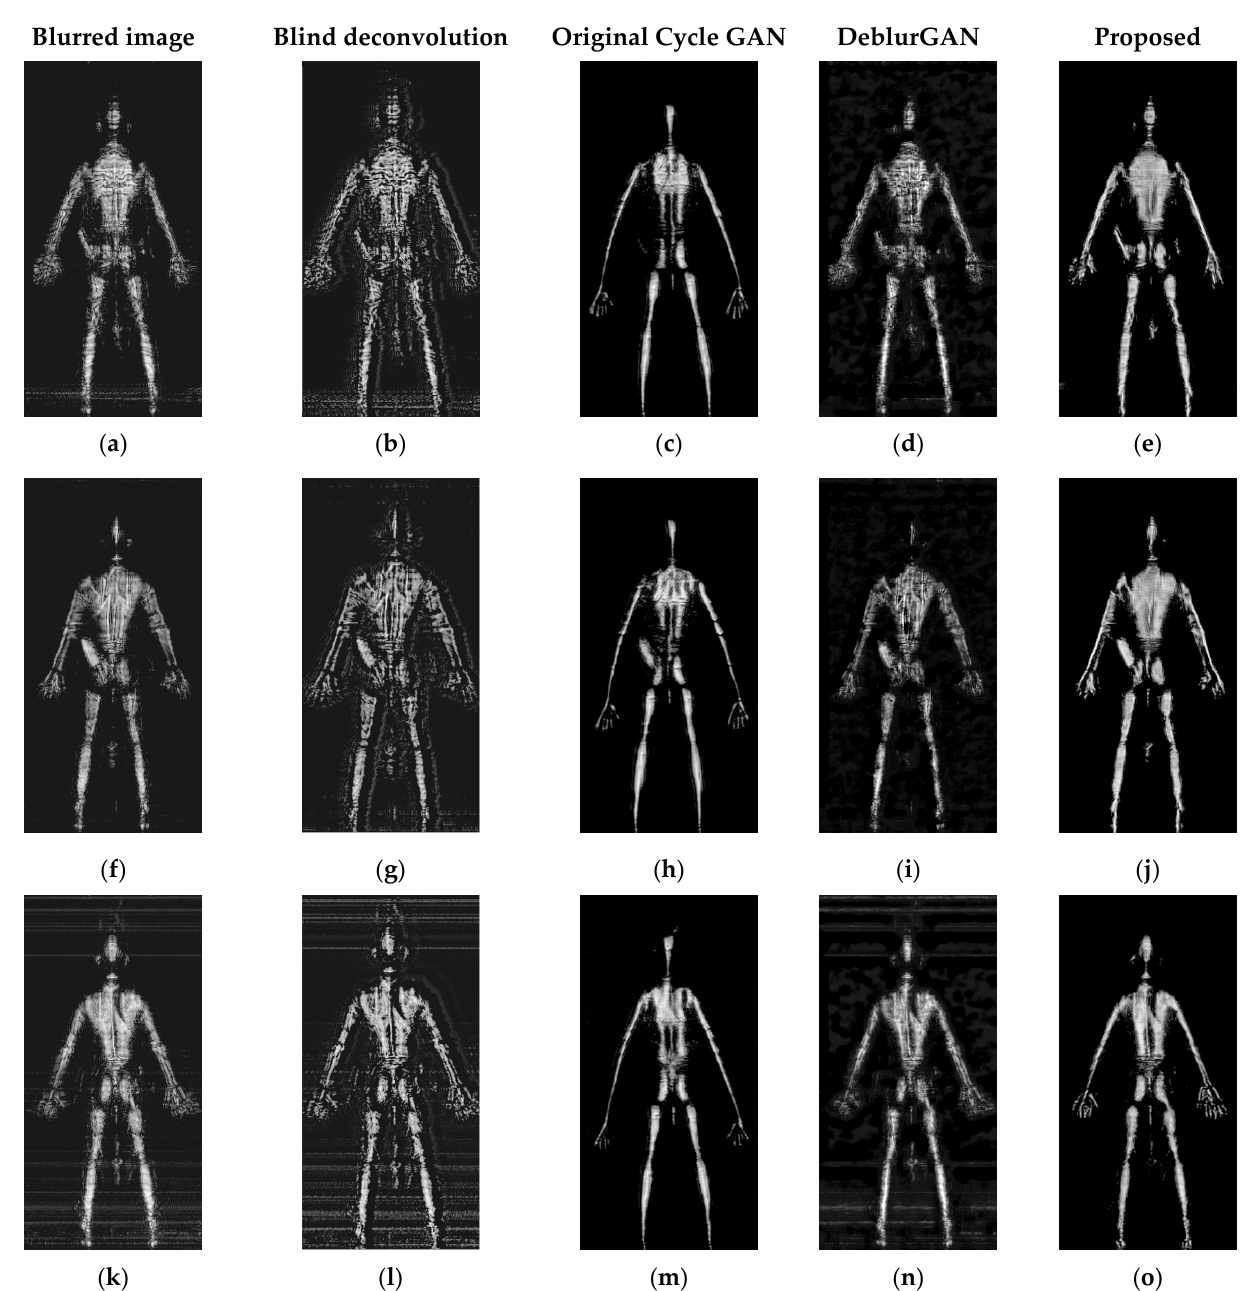
Figure 5. Comparison of various MMW images using different deblurring methods: ( a )–( e ) human body taking a wrench, ( f )–( j ) human body taking a knife and ( k )–( o ) human body taking nothing.